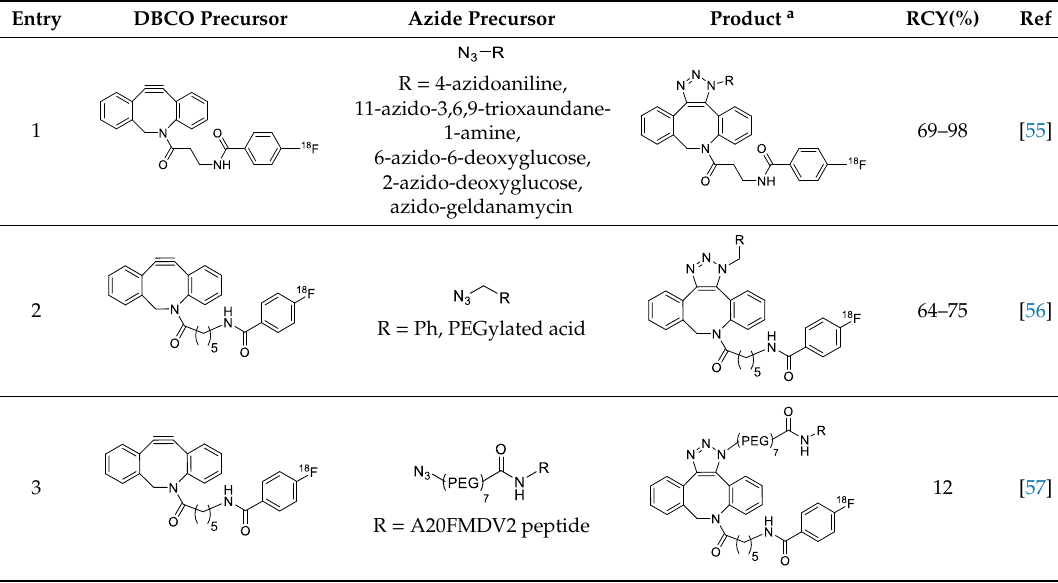
Figure 2. 18 F-radiolabeling of bombesin derivative using SPAAC: a ) human plasma or dimethyl